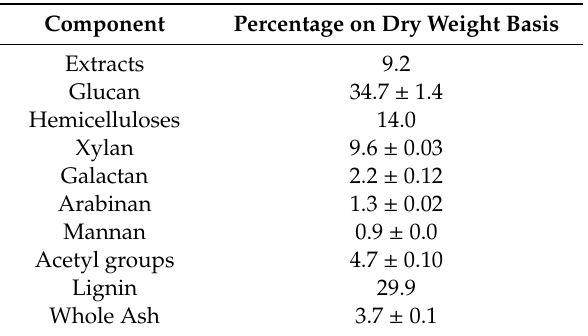
Table 1. MFGW composition. Data are expressed as dry